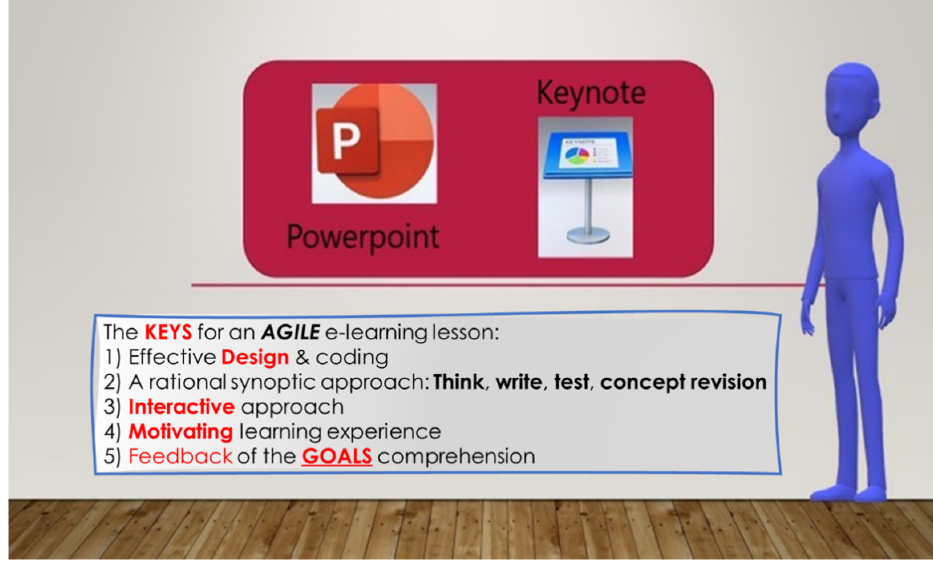
Figure 2. Example of two of the most employed software to create educational content.